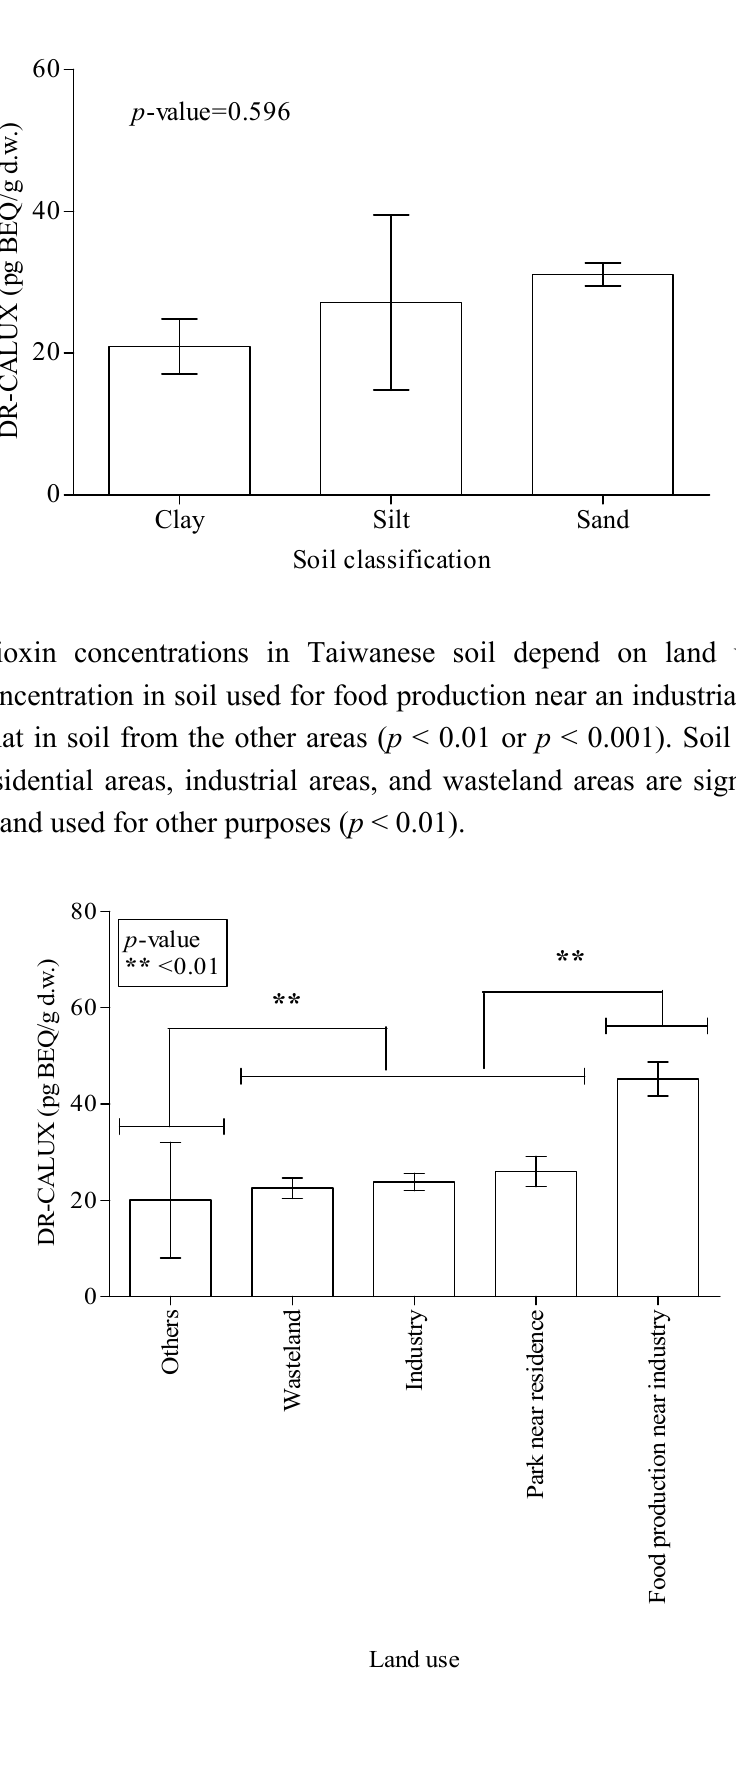
Figure 4. Dioxin-BEQs in clay, silt, and sand in our soil samples (n = 685). Dioxin concentrations are similar among clays, silts, and sands ( p = 0.596).